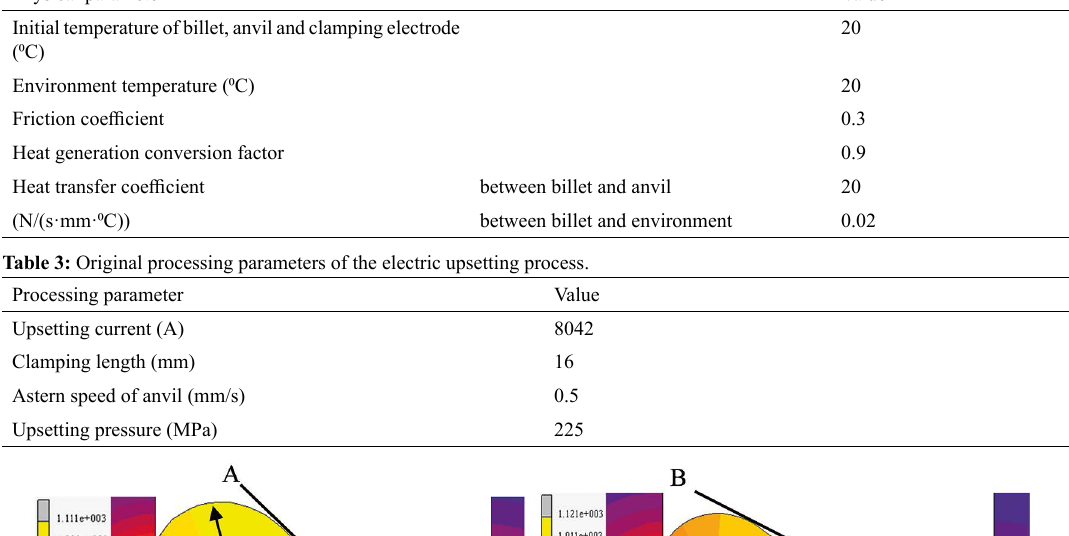
Table 2: Physical parameters of finite element simulation.